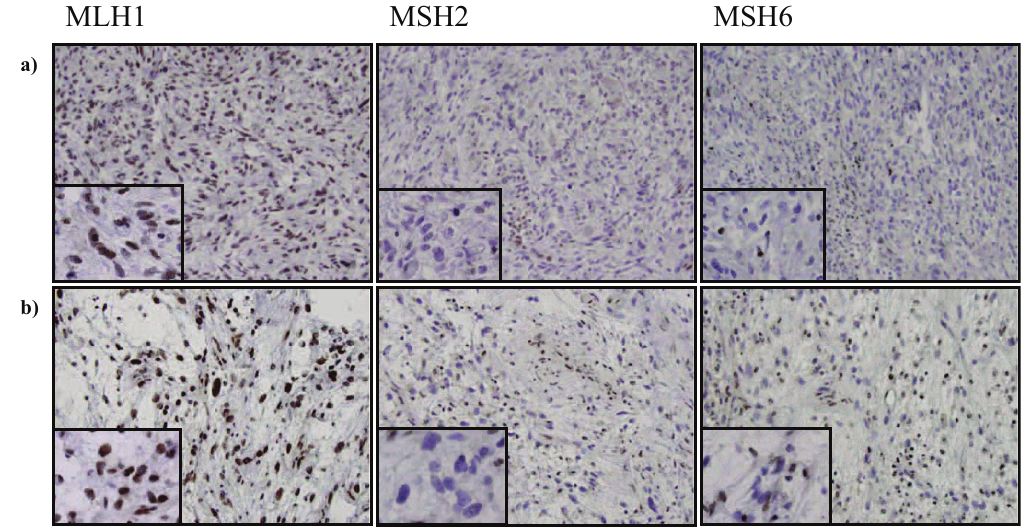
Fig. 1. Loss of immunohistochemical expression of MSH2 and MSH6, with retained expression of MLH1 in a storiform-pleomorphic MFH (a) and a myxoid MFH